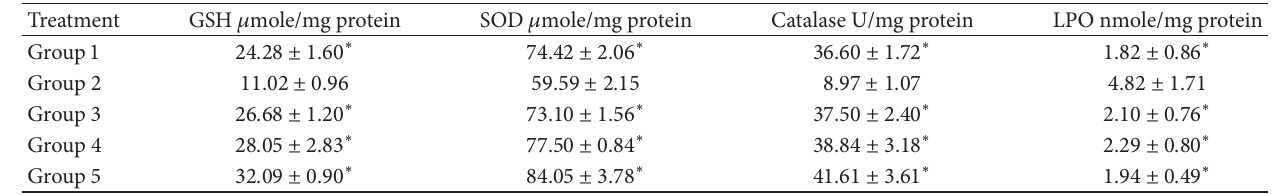
Table 5: Inhibition of dimethylbenz(a)anthracene (DMBA)/croton oil induced skin carcinogenesis in Swiss albino mice by palmatine treatment.